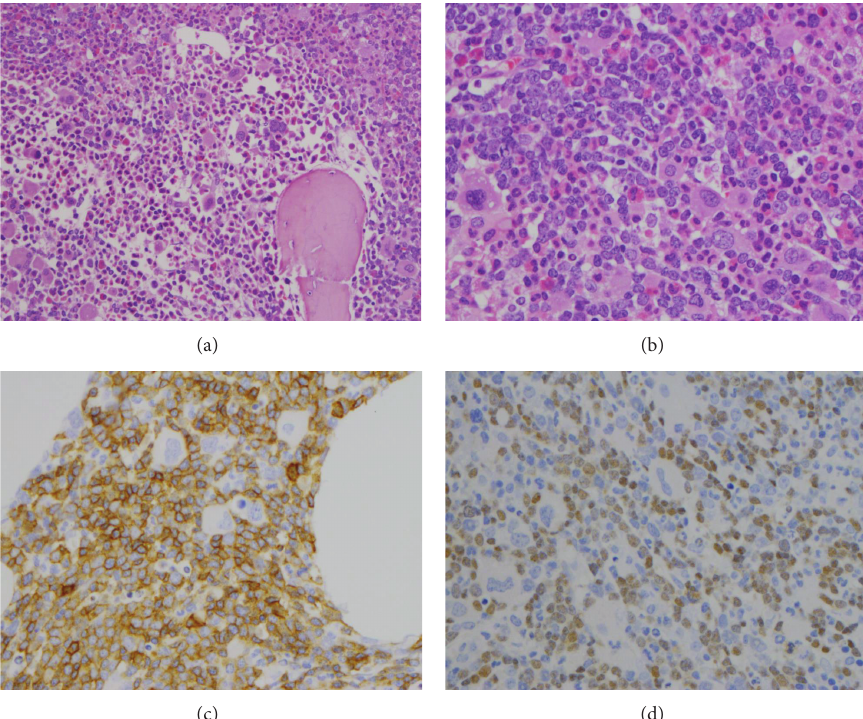
Figure 1: Bone marrow biopsy of Case 1. The bone marrow demonstrated morphologic features of chronic myelogenous leukemia and increased blasts ((a) H&E: 200x; (b) H&E: 400x) with a T-lymphoblastic immunophenotype ((c) CD5: 400x; (d) TdT: